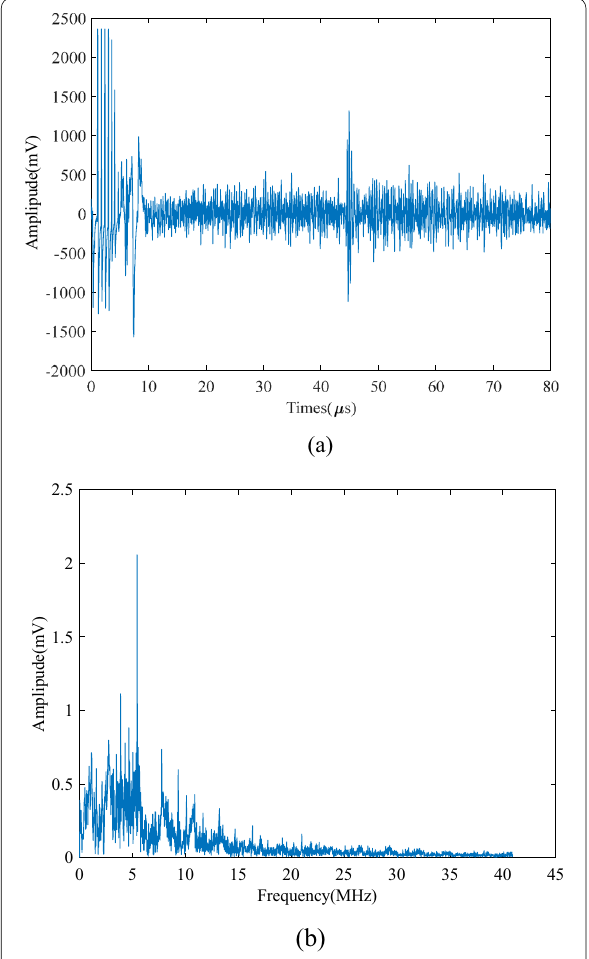
Figure 7 Original ultrasonic signal in ( a ) time domain and ( b ) frequency domain